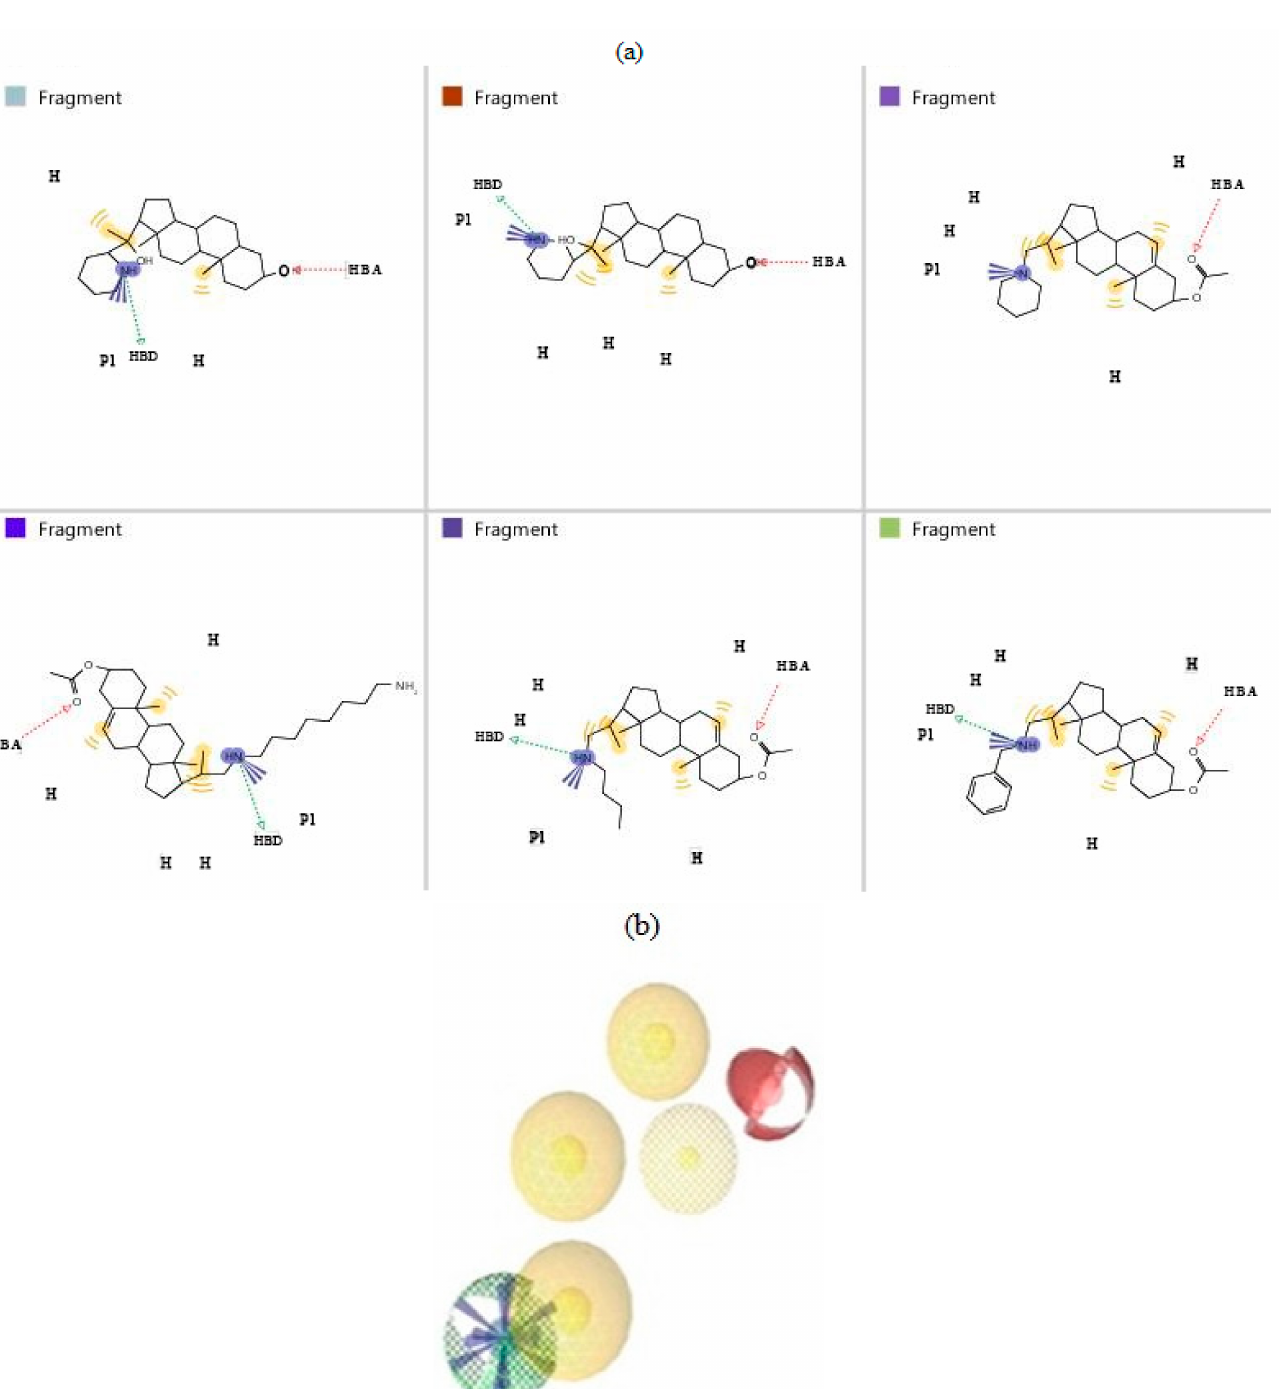
Figure 3. Pharmacophore features generated from ( a ) the six ligands comprising H, PI, HBA, and HBD; and ( b ) the pharmacophore model produced from merging the pharmacophore descriptors of all six inhibitors. Red balls indicate HBA, yellow balls denote H, green regions show HBD, and blue regions represent